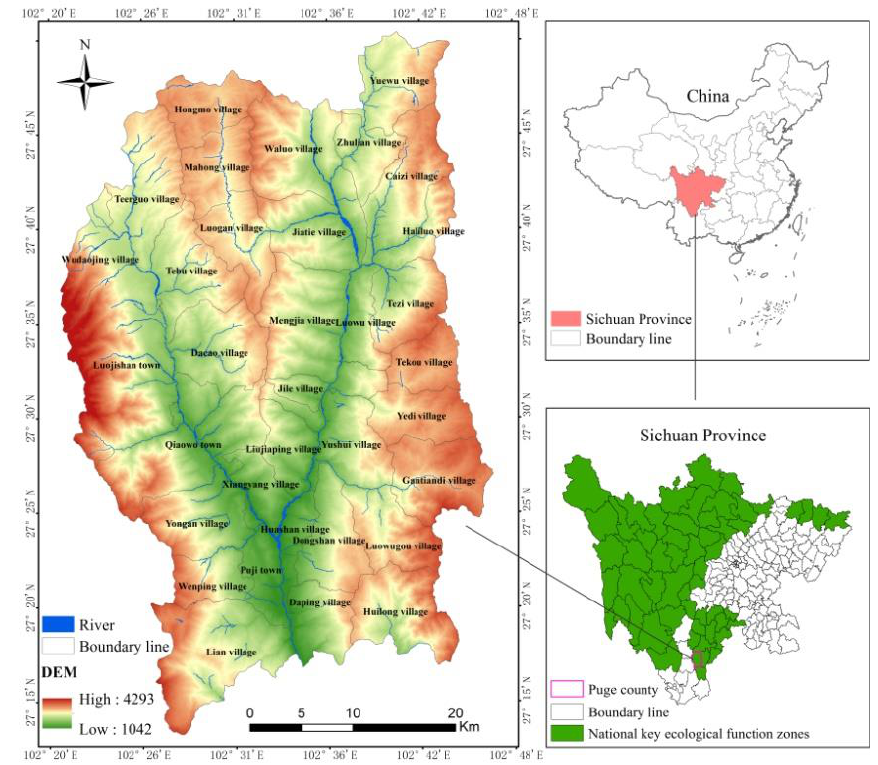
Figure 2. Location map of Puge County.